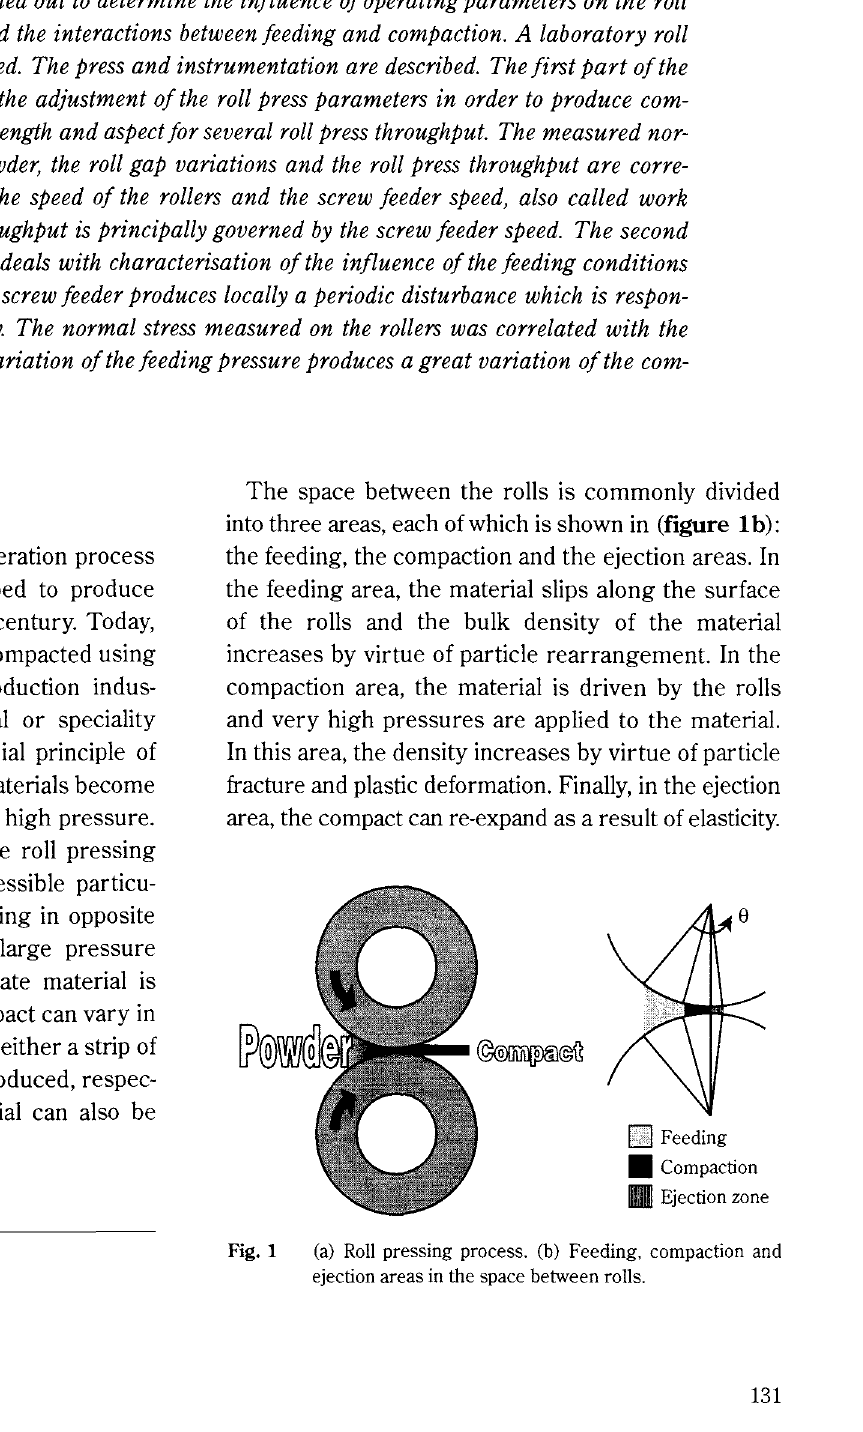
(a) Roll pressing process. (b) Feeding, compaction and ejection areas in the space between